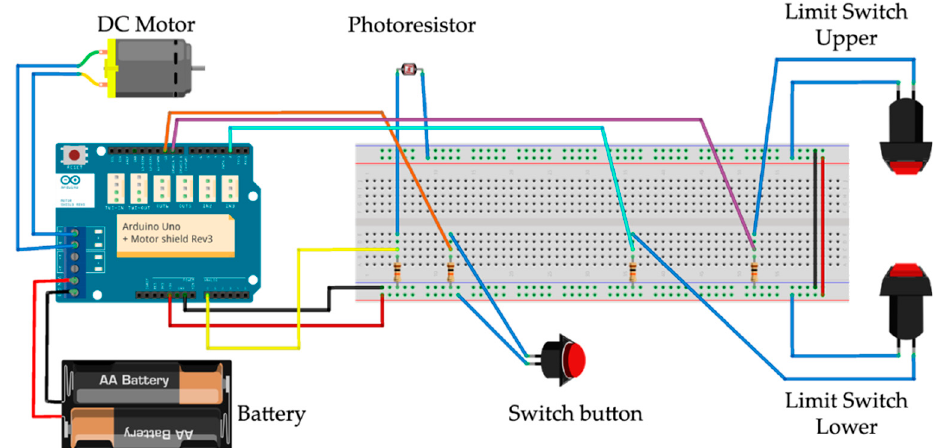
Figure 17. Arduino-based smart chicken coop door, DIY project [72].